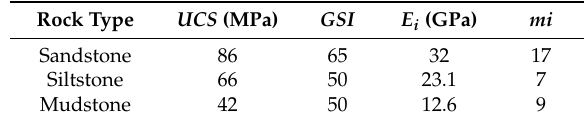
Table 1. GSI and intact rock parameters of different rock units in the headrace tunnel.